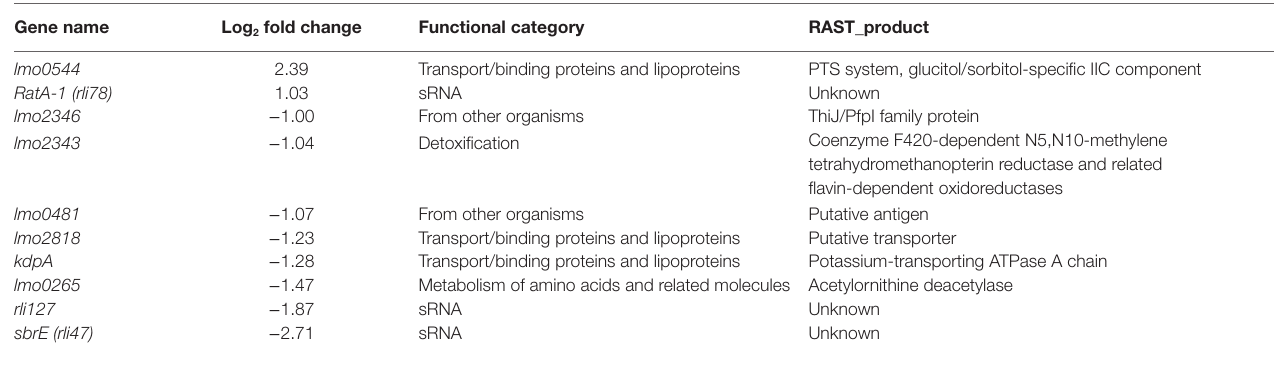
TABLE 3 | Genes with significantly altered gene expression in the presence of visible light, in a Δ sigB